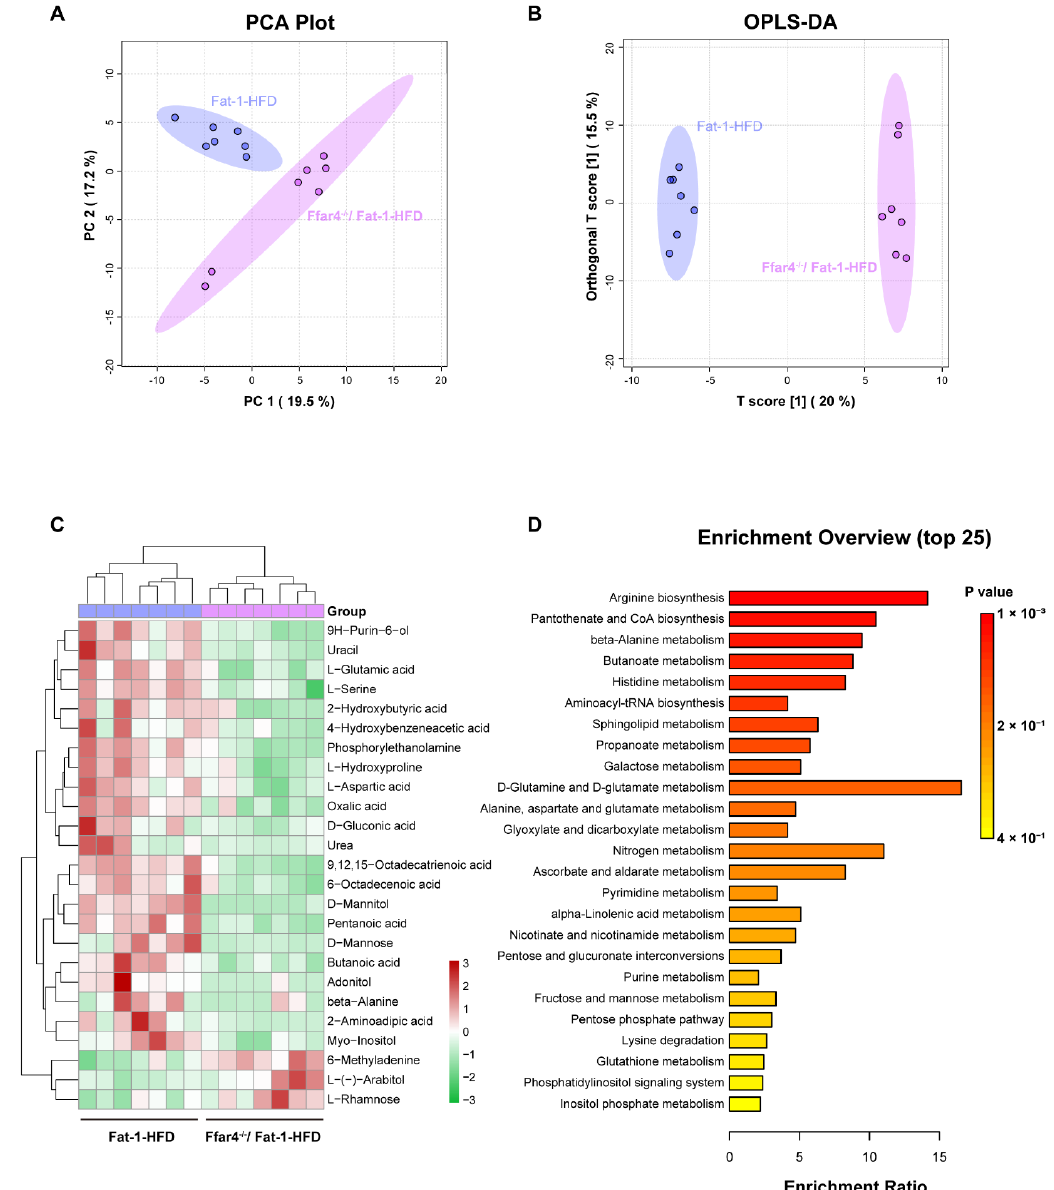
Figure 5. Liver metabolomic analysis. ( A ) PCA score plot. ( B ) OPLS-DA score plot. ( C ) Heat maps of differential metabolites between the Fat-1-HFD and FFAR4 −/− /Fat-1-HFD groups, as determined by VIP > 1 and p < 0.05. ( D ) Overview of the metabolite set enrichment analysis. Results are shown as mean ± SD ( n = 7, per group).